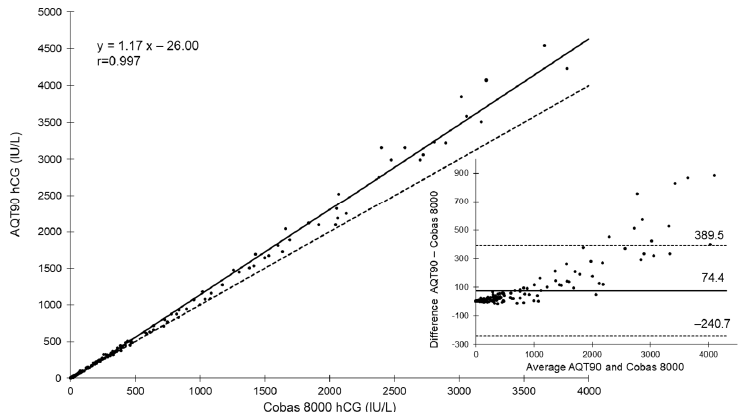
Figure 2. Deming regression ( n = 176) of hCG on e602/Cobas 8000 (plasma) and AQT90 (whole blood) in the ED, and Bland–Altman plot of differences against means for patient samples with both analyzers. The Deming graph shows the regression line (solid line) and identity line (x = y, dashed line).For the Bland–Altman representation, the mean (solid horizontal line) and limits of agreement (dashed lines) of the bias (IU/L) were computed.